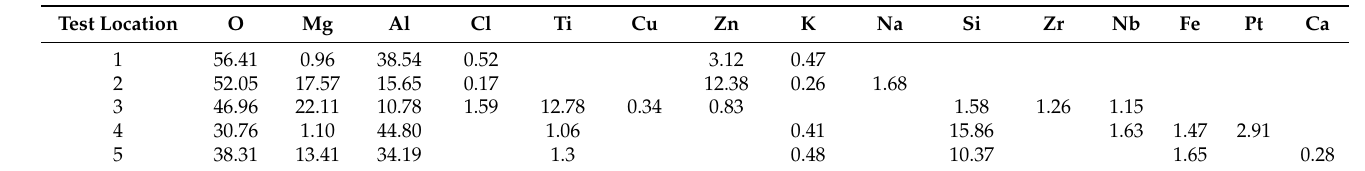
Table 3. Surface composition of the residual aluminum melt sample in the ceramic cavity and the inner surface of the cavity channel (wt%).